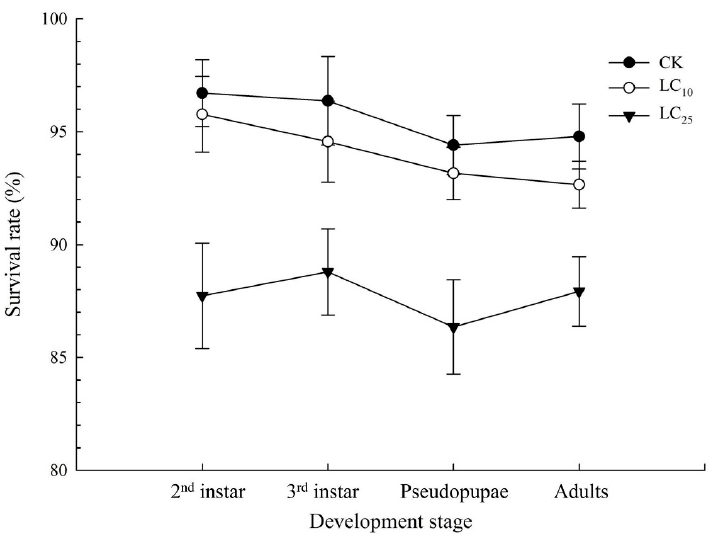
Figure 2. Sublethal effects of afidopyropen (LC 10 and LC 25 ) on survival of specific life stages of B. tabaci MED. CK denotes the control group.